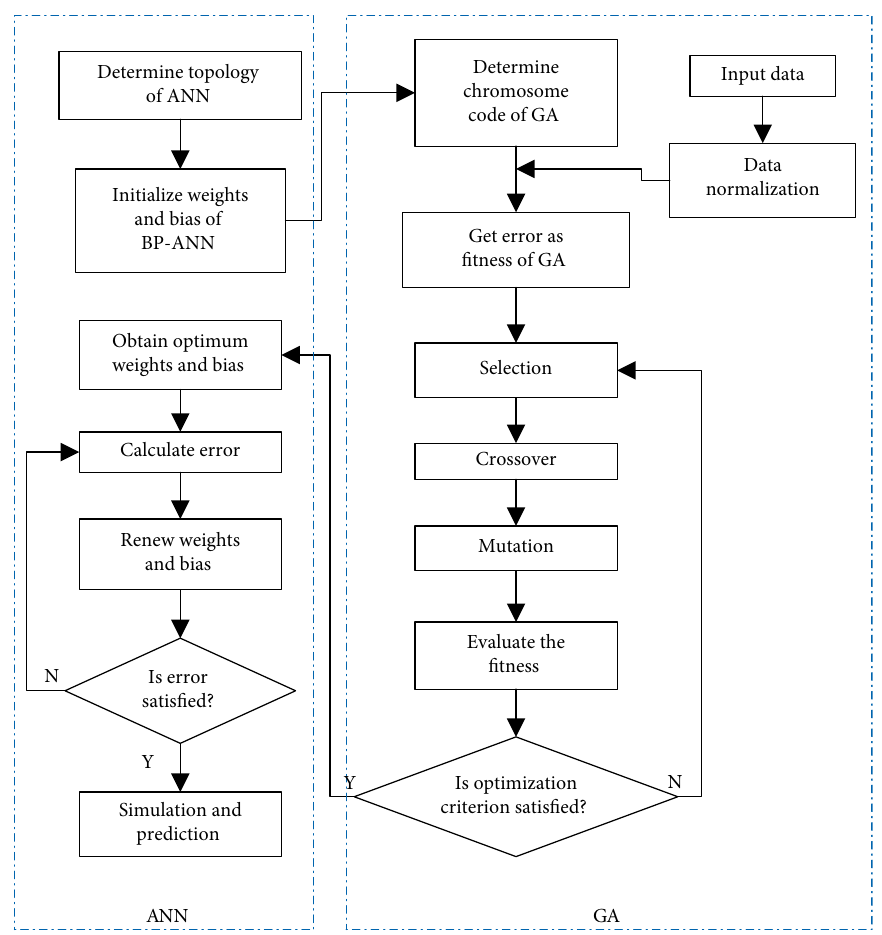
Figure 4: Flow chart of the hybrid model of